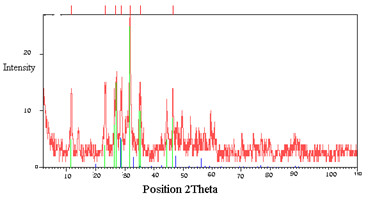
XRD pattern for SPGO. Intensities and diffraction angles were according with the standard reference pattern: CSD-Profan database (ref. code: 00-012-0797).